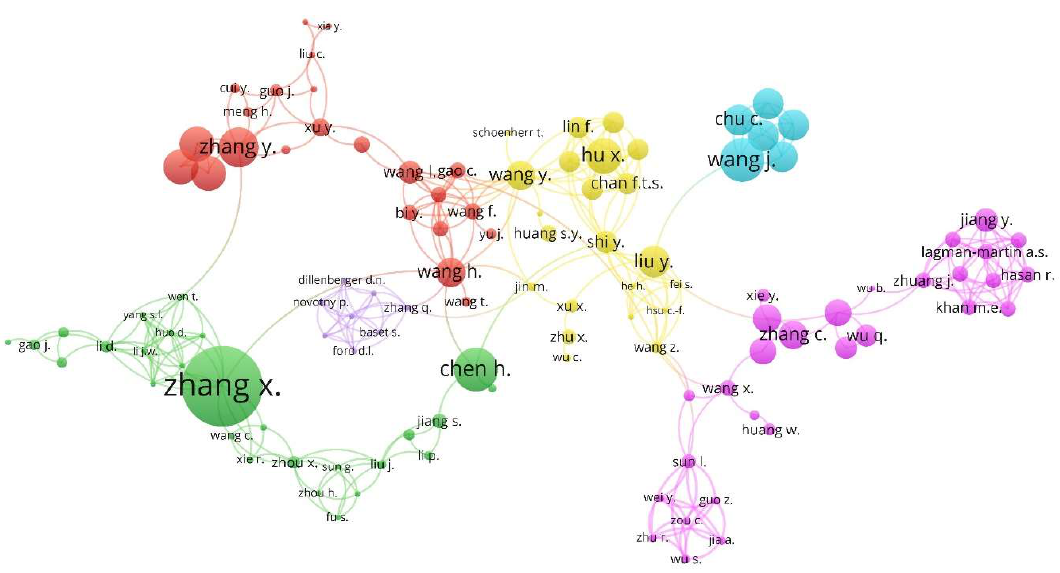
Figure 5. Network of authors based on co-authorship method (1975–2019). Table 13. Top 10 research institutions: main thematic areas and keywords (1975–2019). Keyword 1 Keyword